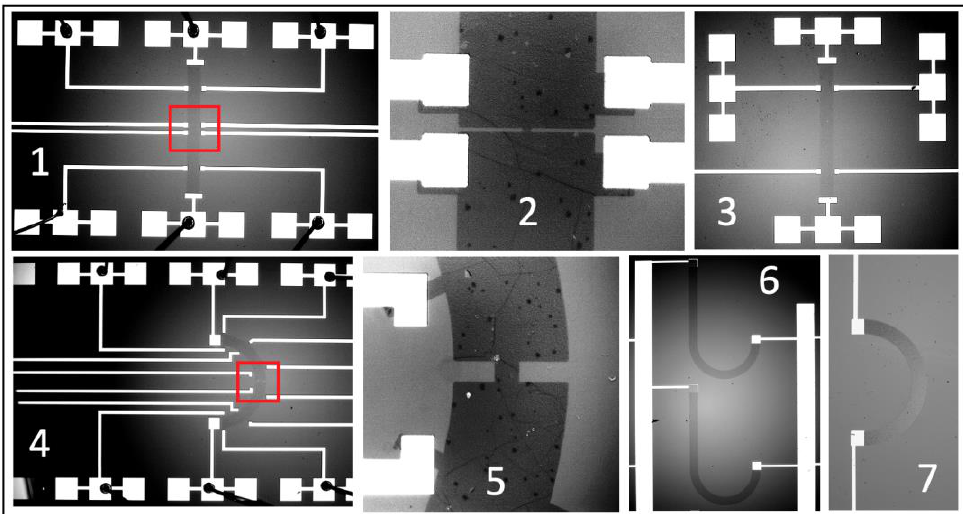
Figure 4. Fabricated devices ( 1 ) A 100 μ m × 1000 μ m Hall Bar with a 5 μ m constriction at 5× magnification. ( 2 ) 40× magnification of the 5 μ m constriction from ( 1 ). ( 3 ) A 100 μ m × 1000 μ m Hall Bar at 5× magnification. ( 4 ) A 100 μ m × 1000 μ m arc with a 20 μ m constriction at 5× magnification. ( 5 ) 40× magnification of the 20 μ m constriction from ( 4 ). ( 6 , 7 ) 100 μ m × 1000 μ m arc elements of a 4 × 4 array at 5× magnification. Images were taken with low illumination to increase the contrast and visibility of the graphene areas.